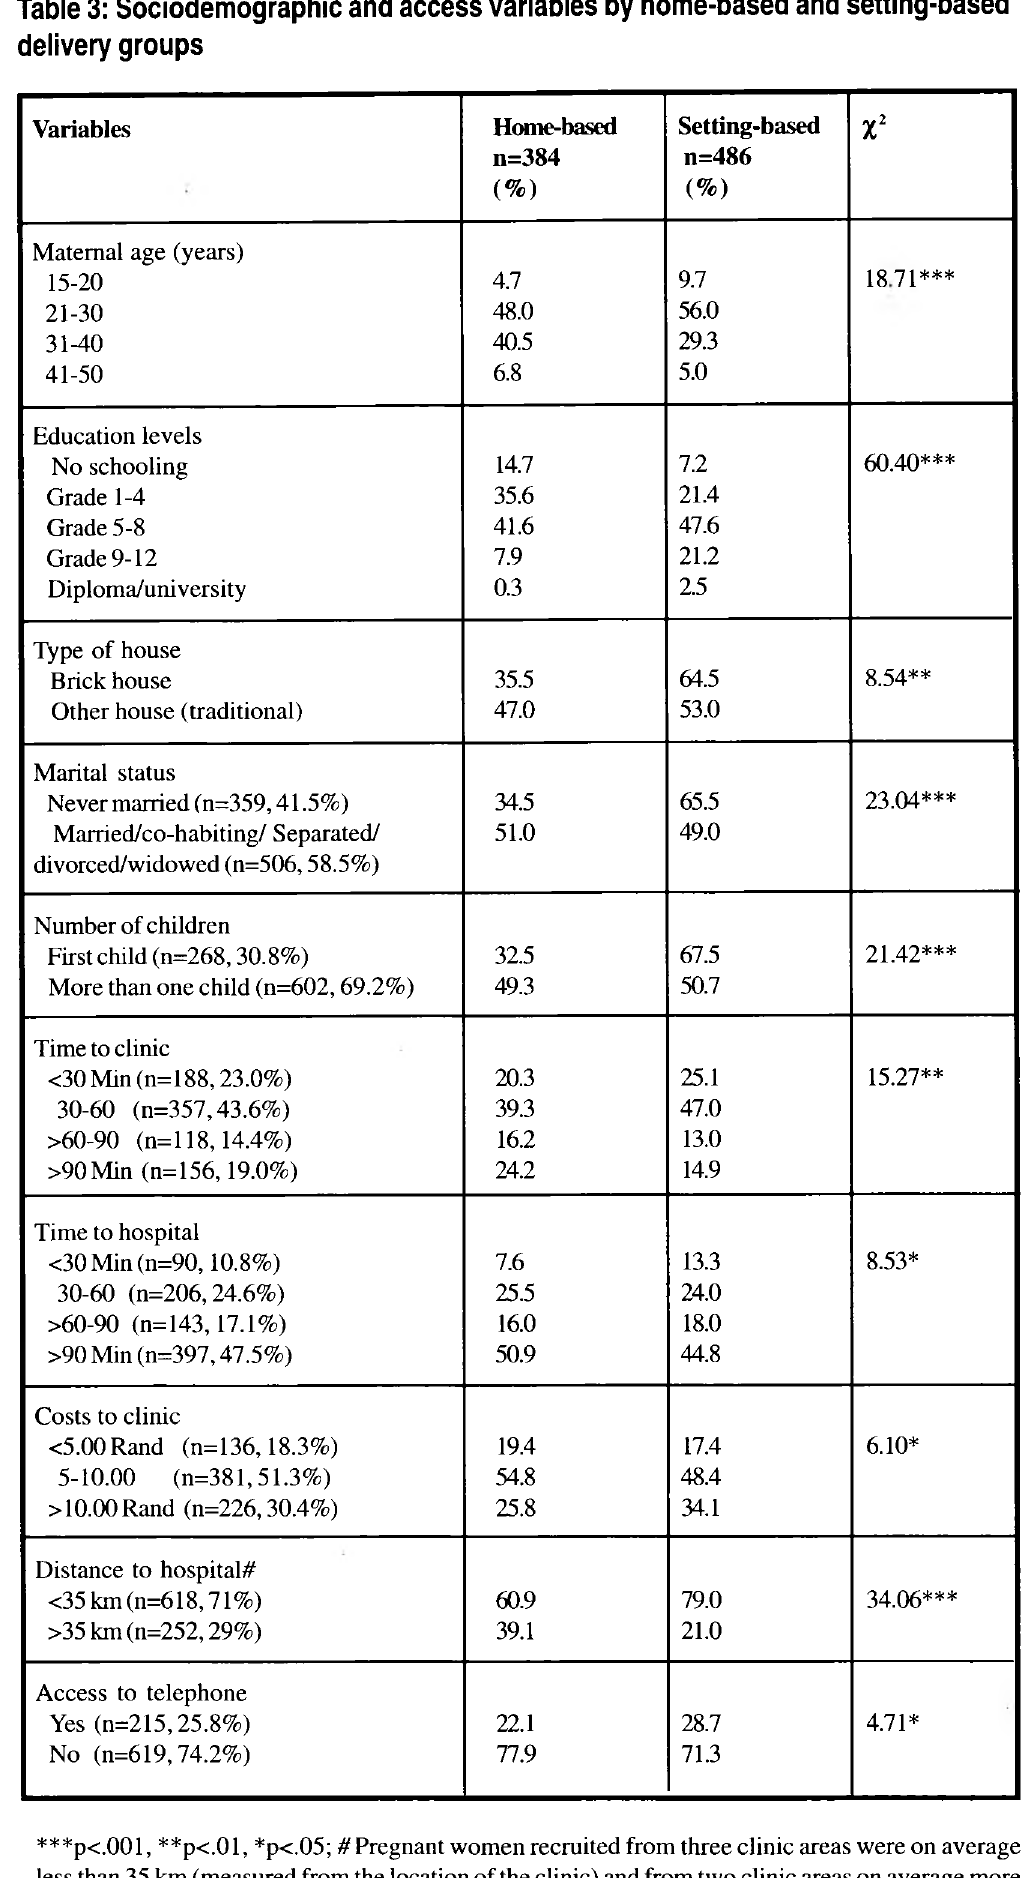
Table 3: Sociodemographic and access variables by home-based and setting-based delivery